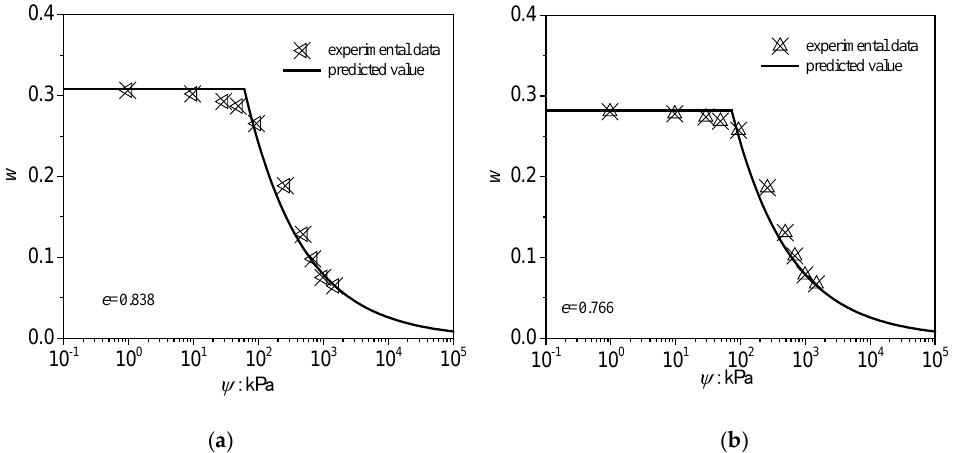
Figure 8. Measured and predicted SWCCs for Hefei expansive soils at deformed state at ( a ) e = 0.838; ( b ) e = 0.766 (data after Miao et al. [42]).